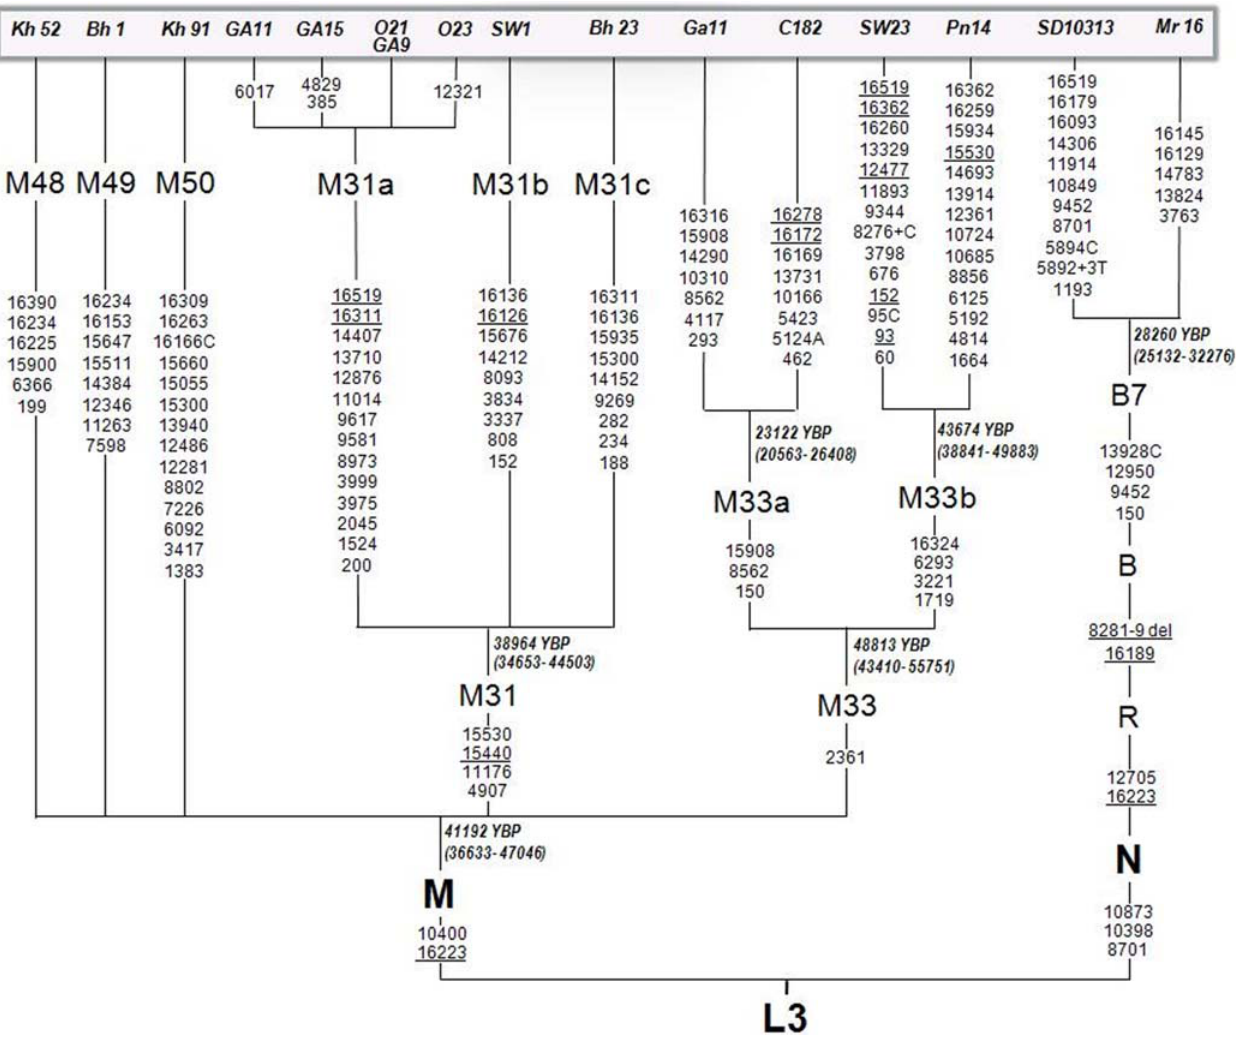
Figure 4. Phylogenetic tree of new haplogroups based on full mtDNA along with the TMRCA and associated 95% Confidence Interval. The samples names are on the tip of the haplogroups. The comparative data, for which sample names are written in capital letters, are from Kong et al. [17], Thangaraj et al. [3], Sun et al. [16] and Palanichamy et al. [19].